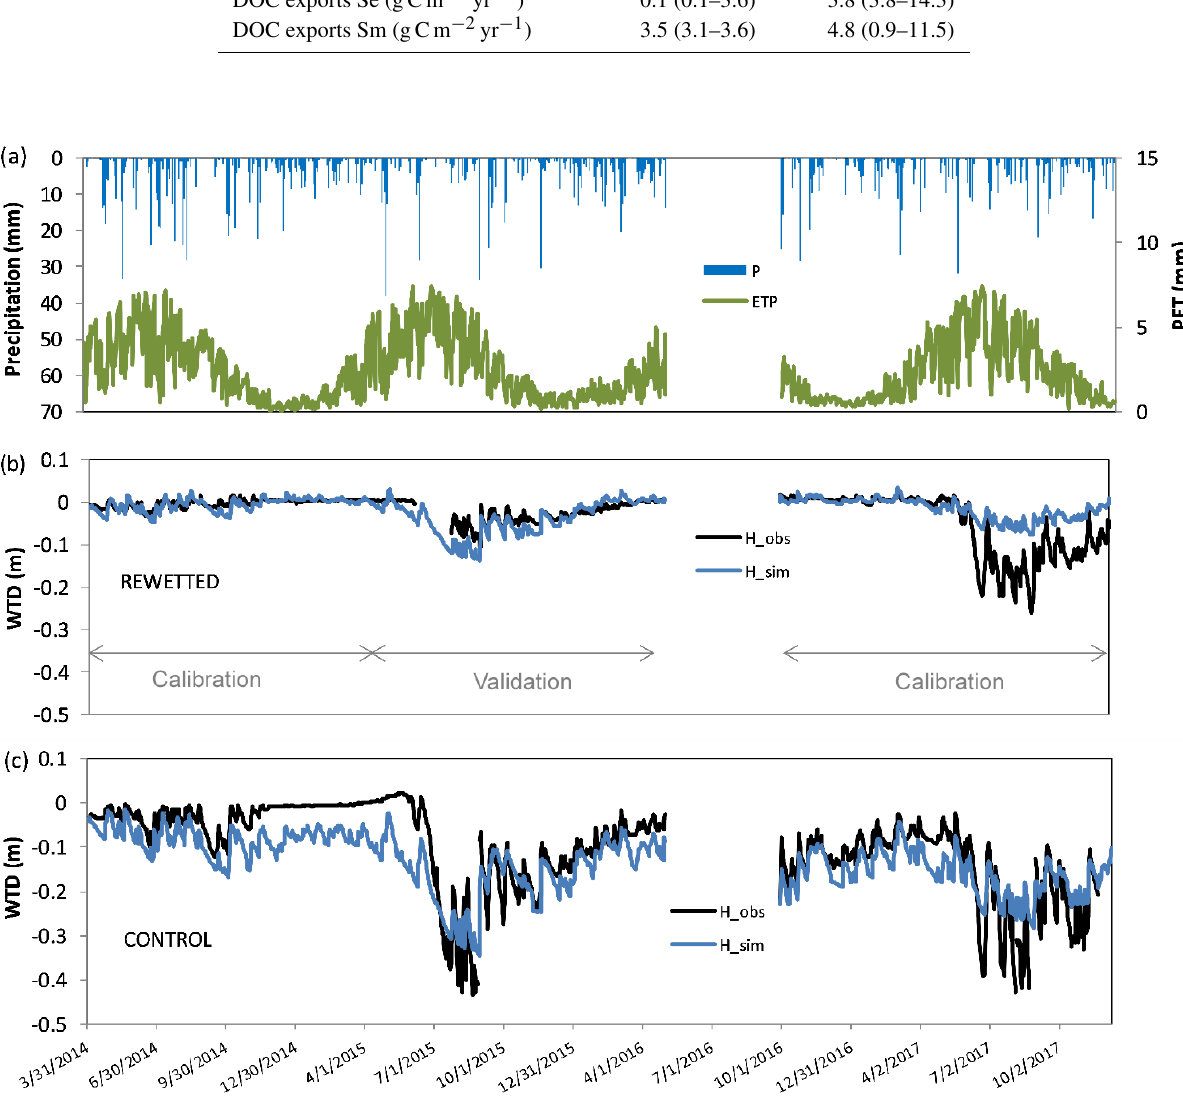
Figure 3. (a) Time series of meteorological data (PET, potential evapotranspiration and P , precipitation) used as input data in the hydro- logical model, (b) simulated (blue) and observed (black) WTD in the rewetted site and (c) simulated and observed WTD in the control site. Calibration and validation periods are also